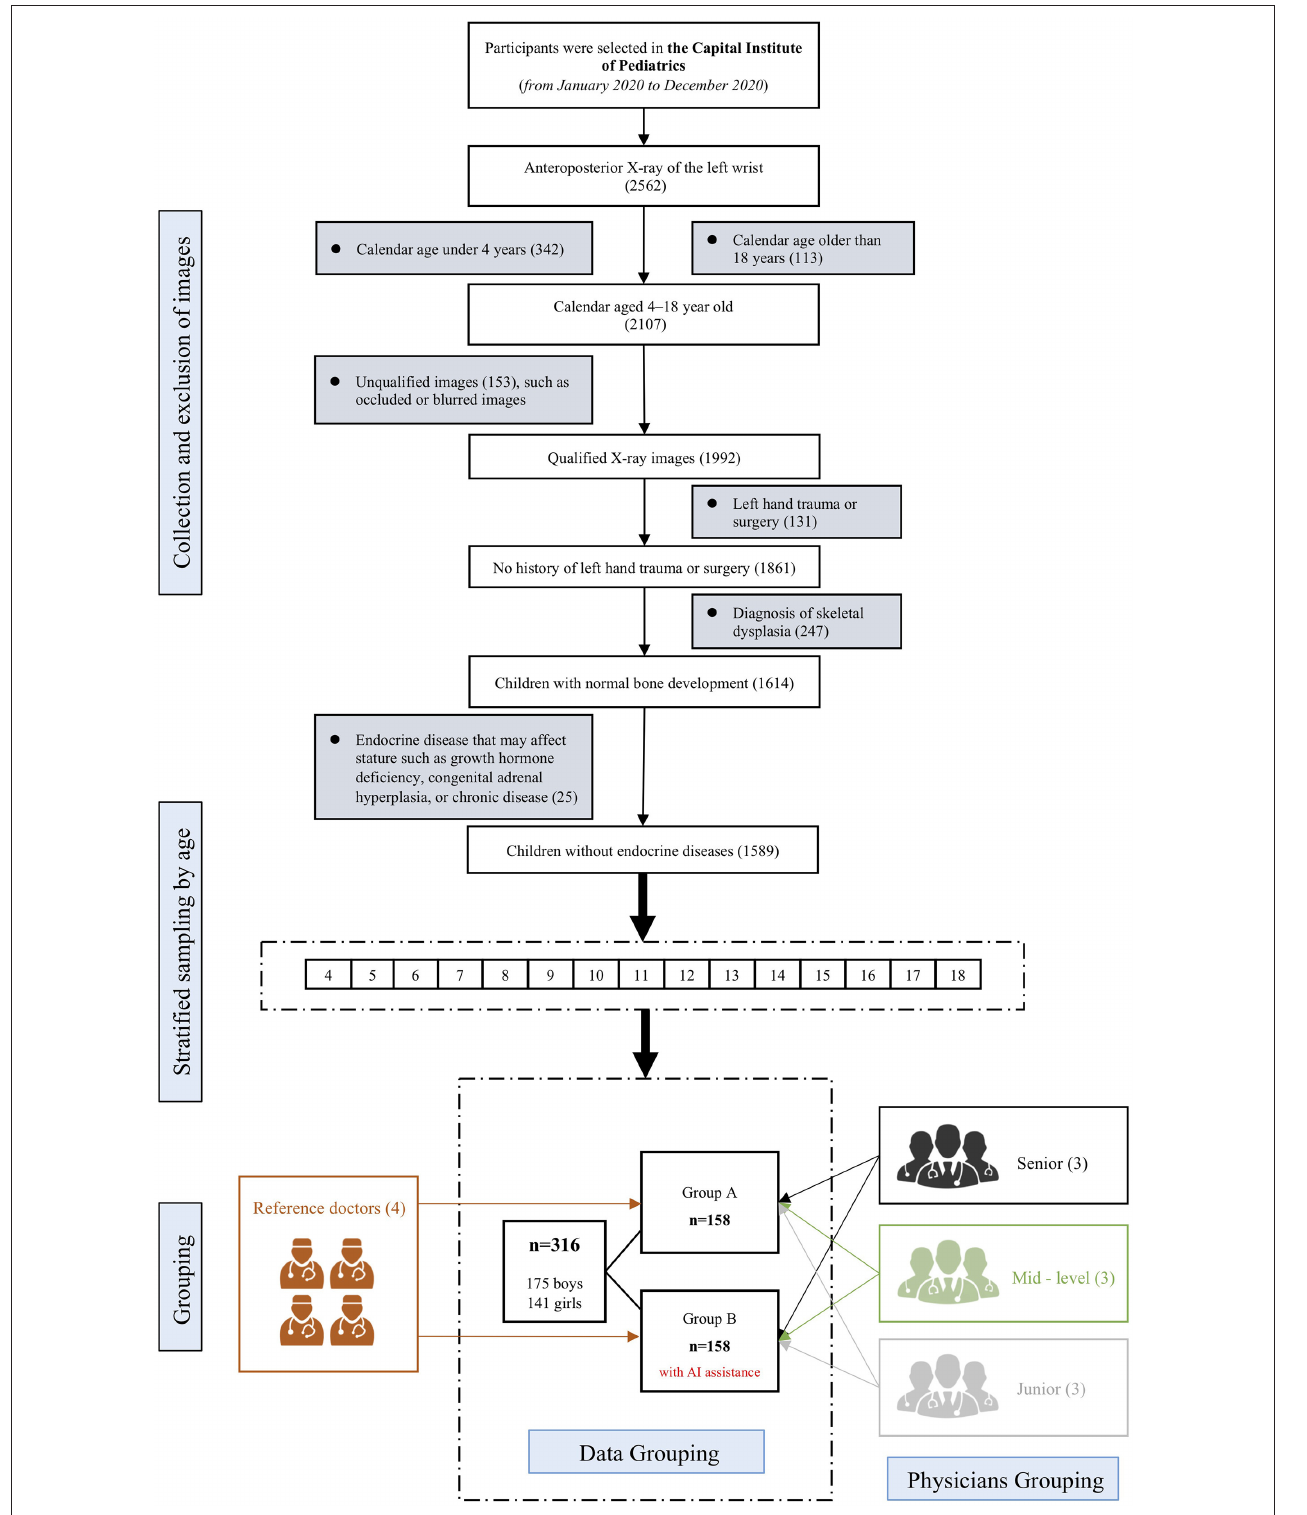
FIGURE 1 | Study design flowchart. The upper part illustrates inclusion and exclusion criteria. After stratified sampling by age, an age-balanced cohort of 316 samples were extracted, which were further randomly divided into group A and group B, each with 158 samples. Both groups were independently evaluated by 4 reference standard experts and 9 physicians of different levels of experience. For group B, the 9 physicians were given AI reports before performing BAA by themselves.